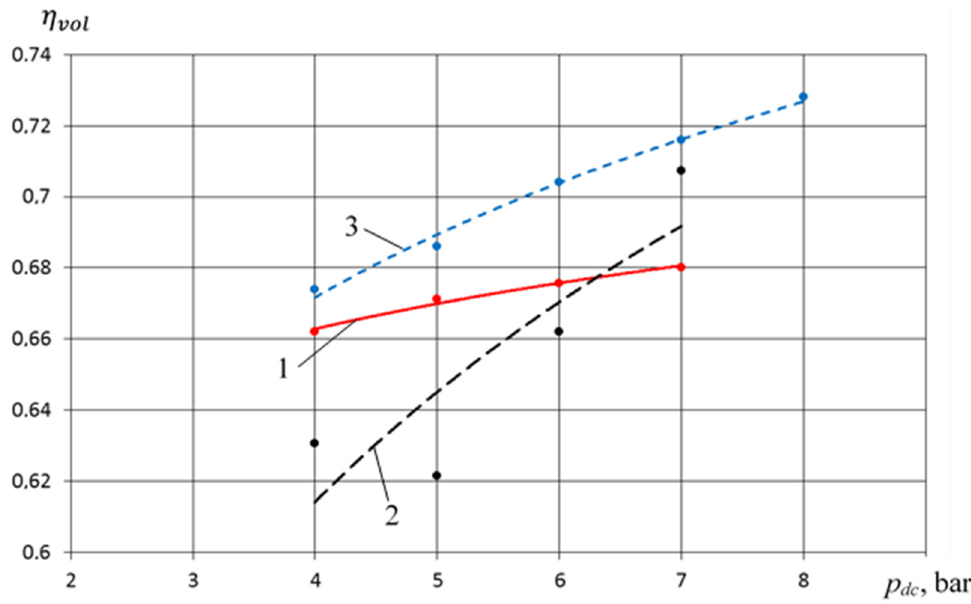
Figure 34. Volumetric efficiency of the pump section from the discharge pressure of the compressor section (1—PHPM with step-type gap seals; 2—PHPM with a smooth gap seal; 3—Crosshead-free PHPM).